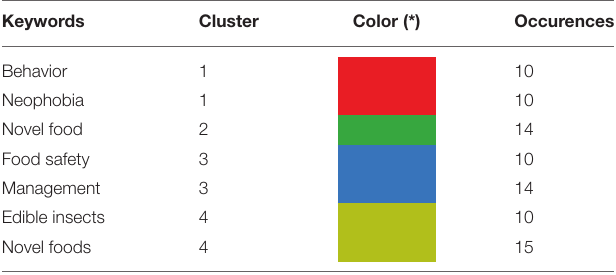
The colors in the table are in line with colors from Figure (Source: our